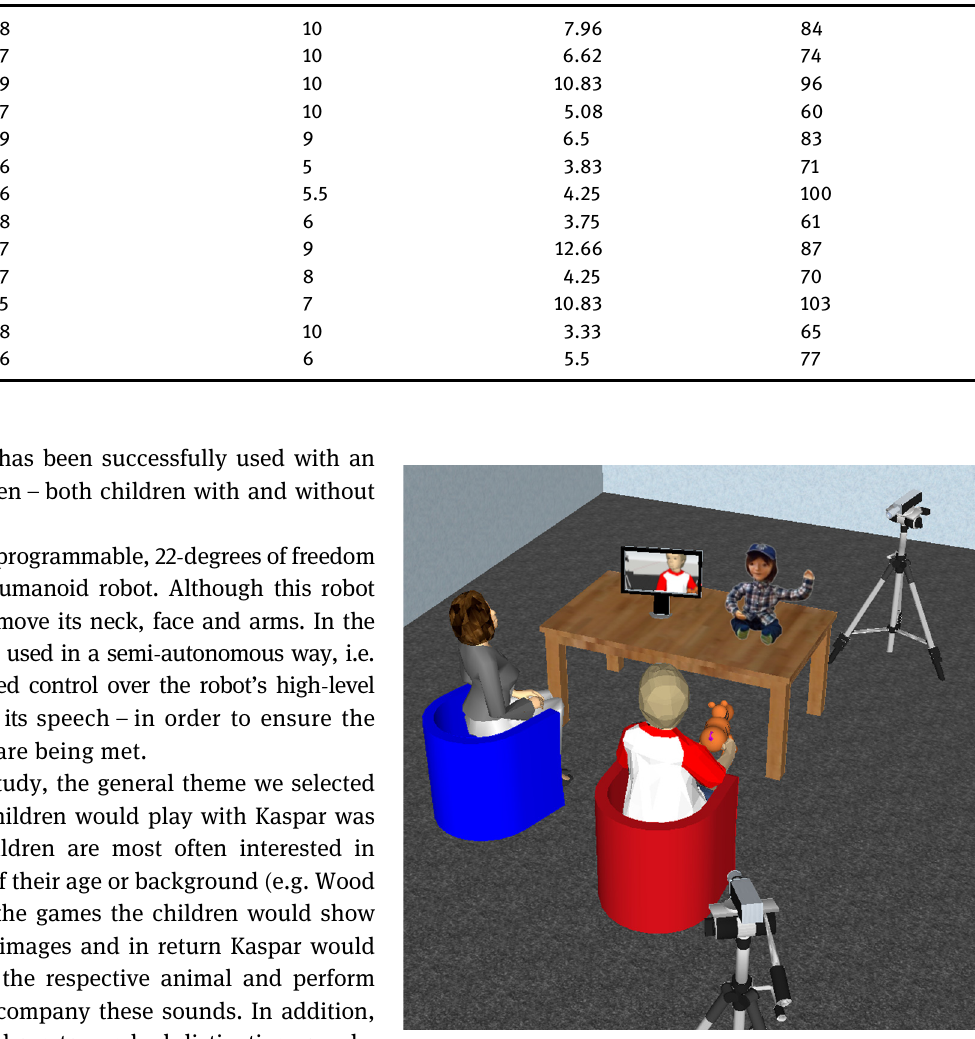
Figure 1: Generic equipment layout: the child is sitting in the red chair facing Kaspar, while the experimenter is sitting in the blue